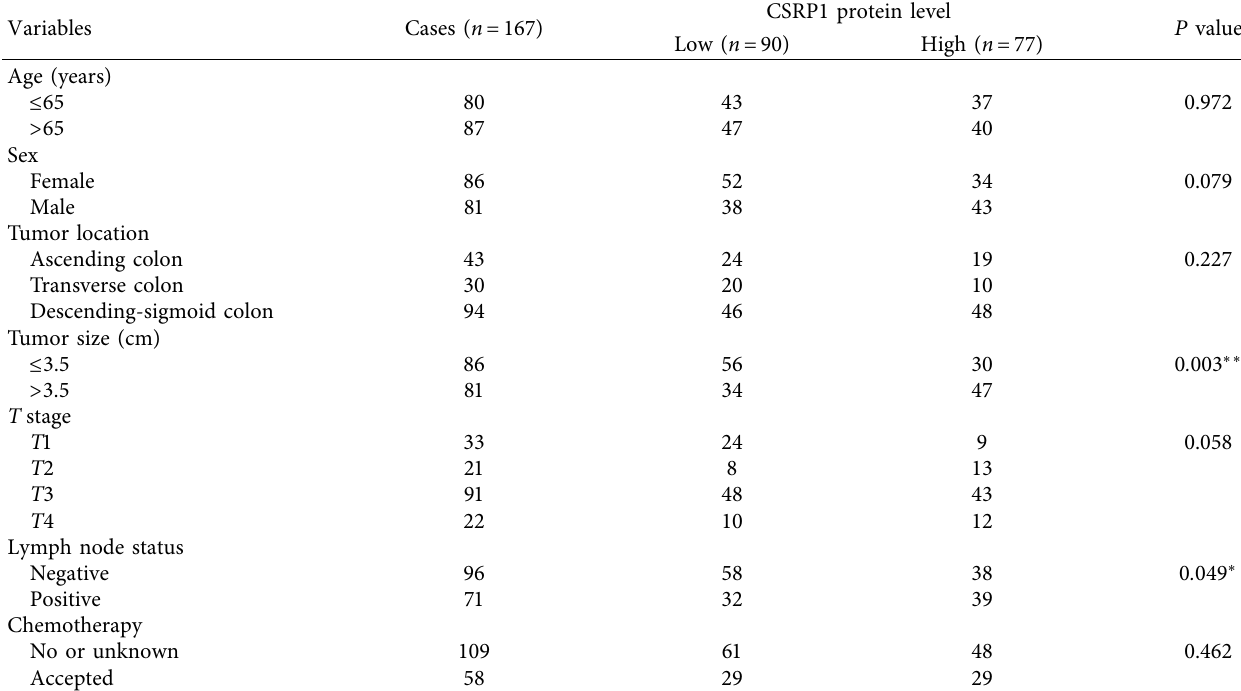
Table 1: Correlations between CSRP1 expression and COAD patients’ characteristics.